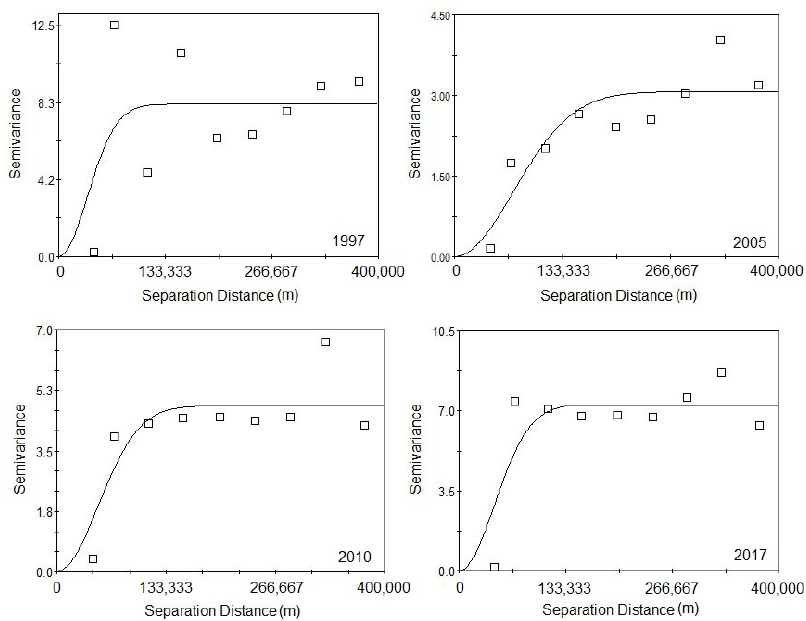
Figure 5. Semi-variance function analysis of carbon emission intensity in the Yangtze River Delta from 1997 to 2017.